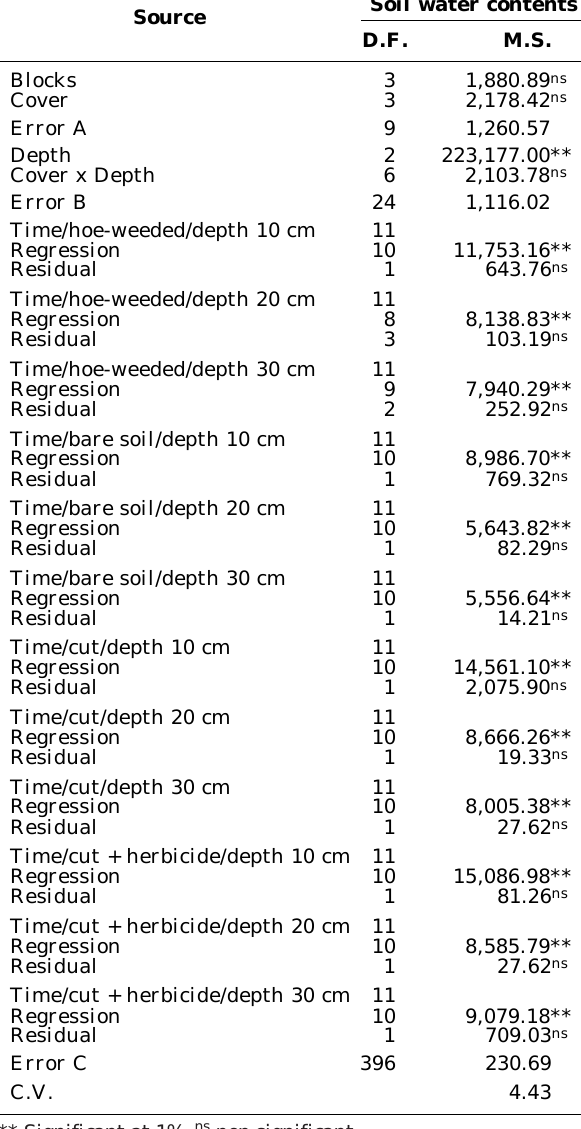
Table 4. Analysis of variance of soil water content